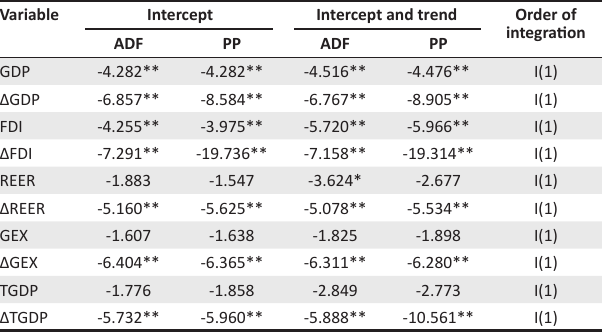
TABLE 2: A summary of unit root